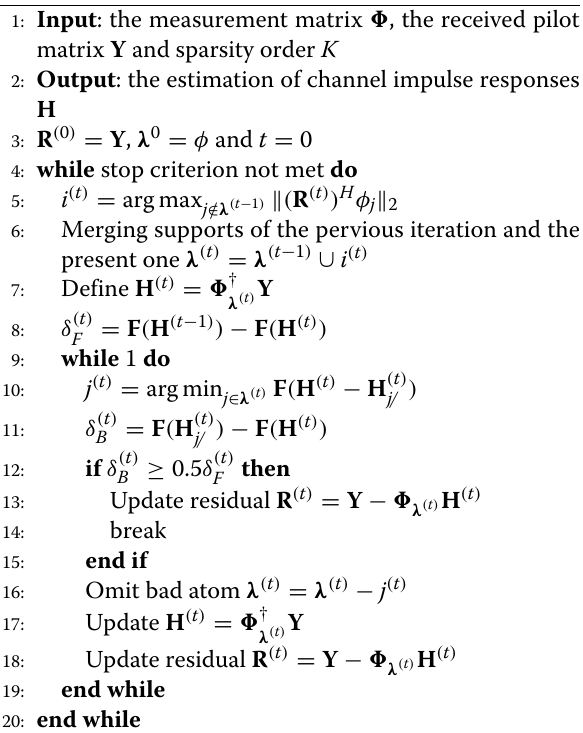
Algorithm 1 FBP-based channel estimation matrix Y and sparsity order